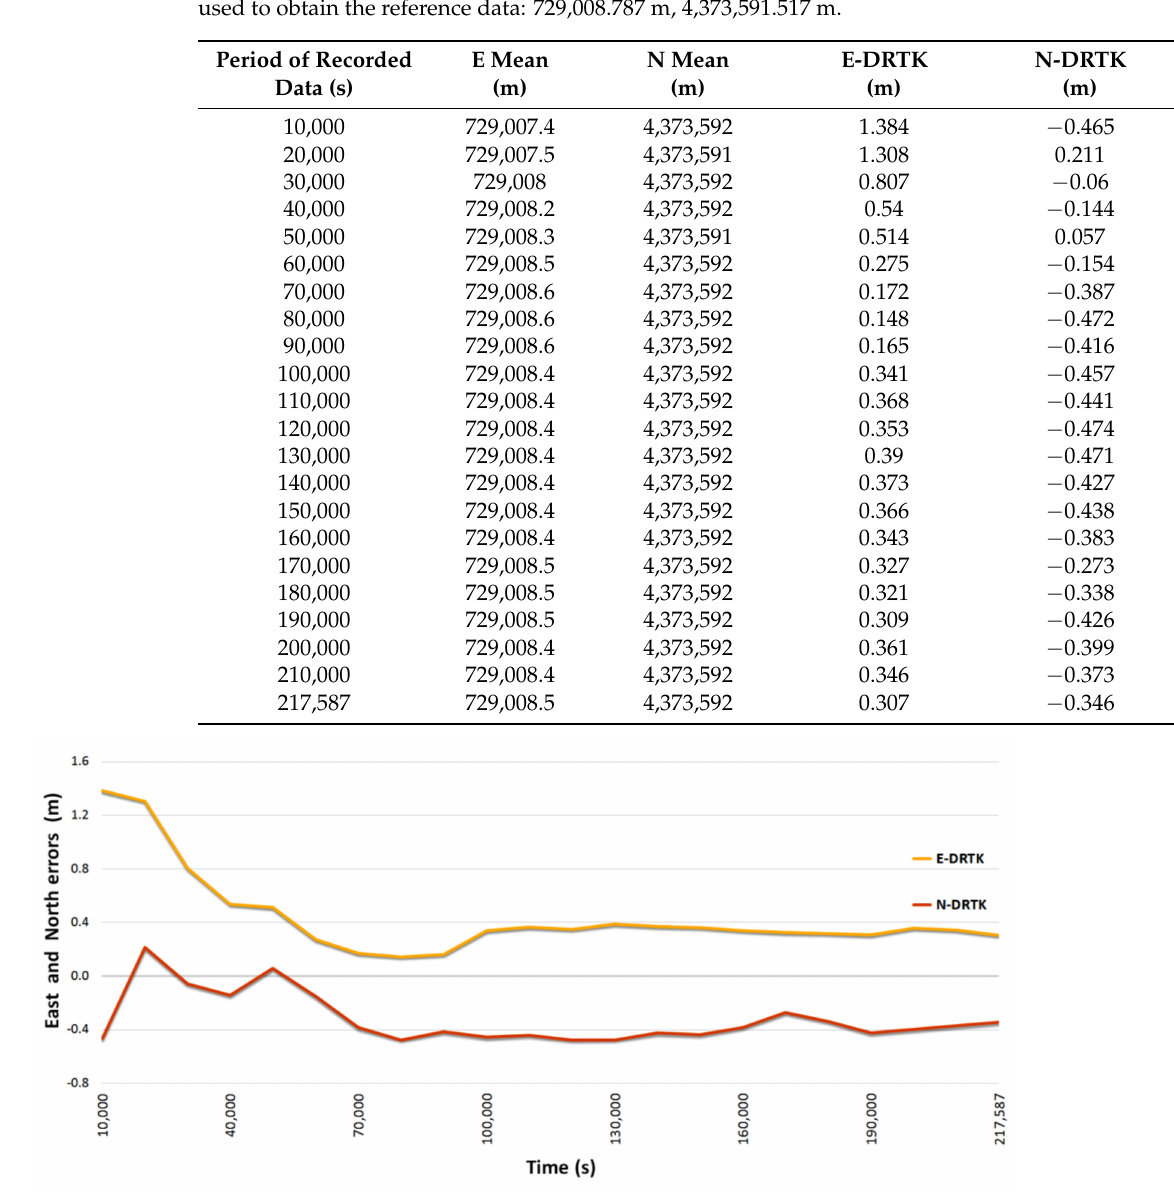
Figure A5. The relationship between the time and the East and North errors of Xiaomi Mi 8 device. East and North errors are the differences between the control point and coordinate means. Table A6. The d E , d N error from the E, N coordinates obtained from the mean of different numbers of observations.